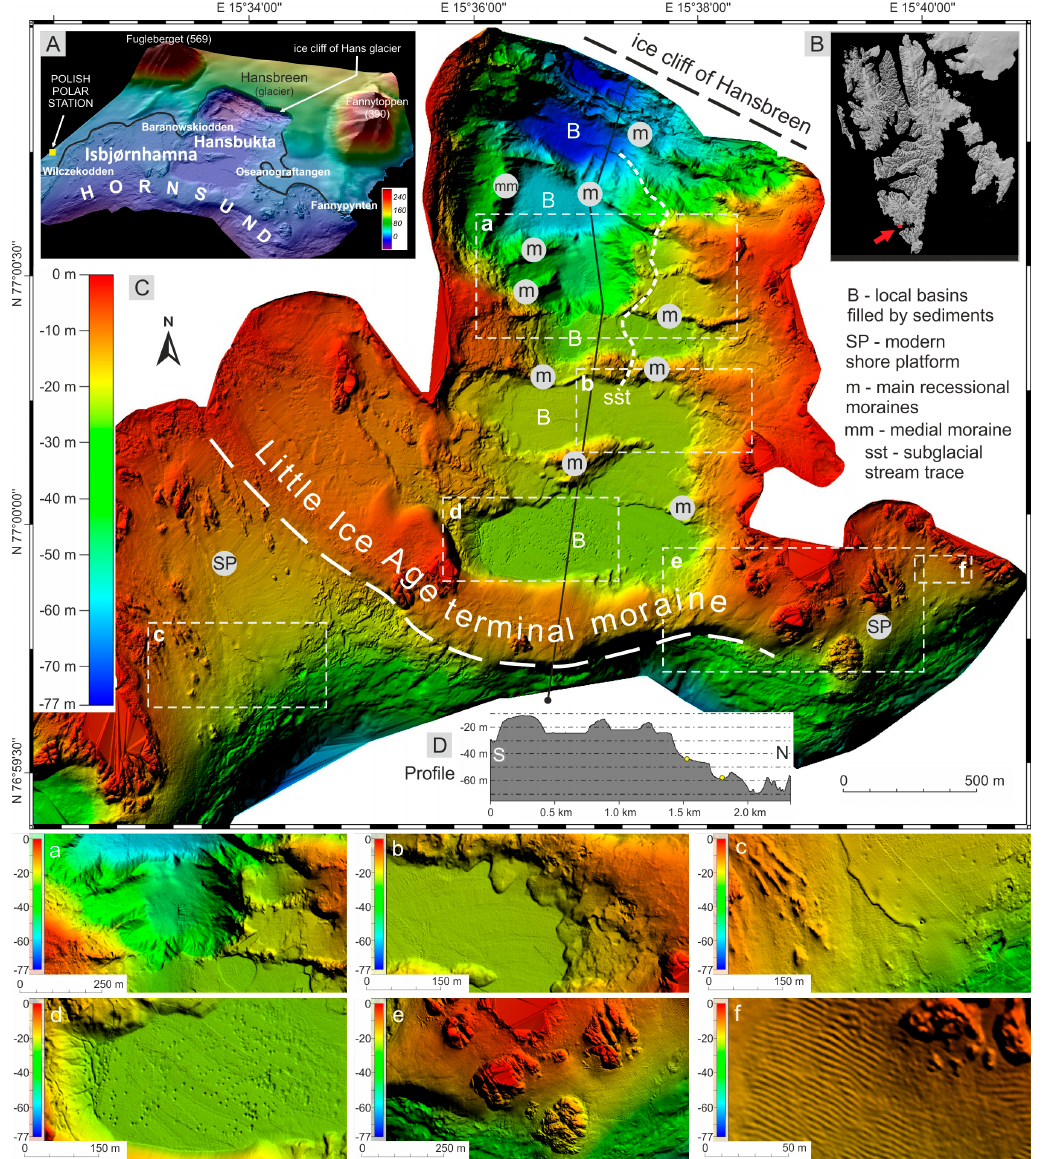
Figure 1. ( A ) Study area, a combination of the bathymetric model and DTM (source: S0 Terrengmodell, Norwegian Polar Institute, Tromsø, Norway, Creative Commons); ( B ) location of the study area in Svalbard; ( C ) seabed morphology of Isbjørnhamna and Hansbukta Bays in Hornsund Fjord; ( a ) recessional moraines eroded (overridden) during the glacier advance; ( b ) tongues from underwater mudslides over fine-grained seafloor; ( c ) seabed with mass-movement landforms; ( d ) pockmarks formed by thermogenic gases; ( e ) N–S cracked exposed bedrock mounds (amphibolites and quartzites) [43]; ( f ) symmetrical megaripples on fine seabed sediments; ( D ) bathymetric profile along indicated black line.